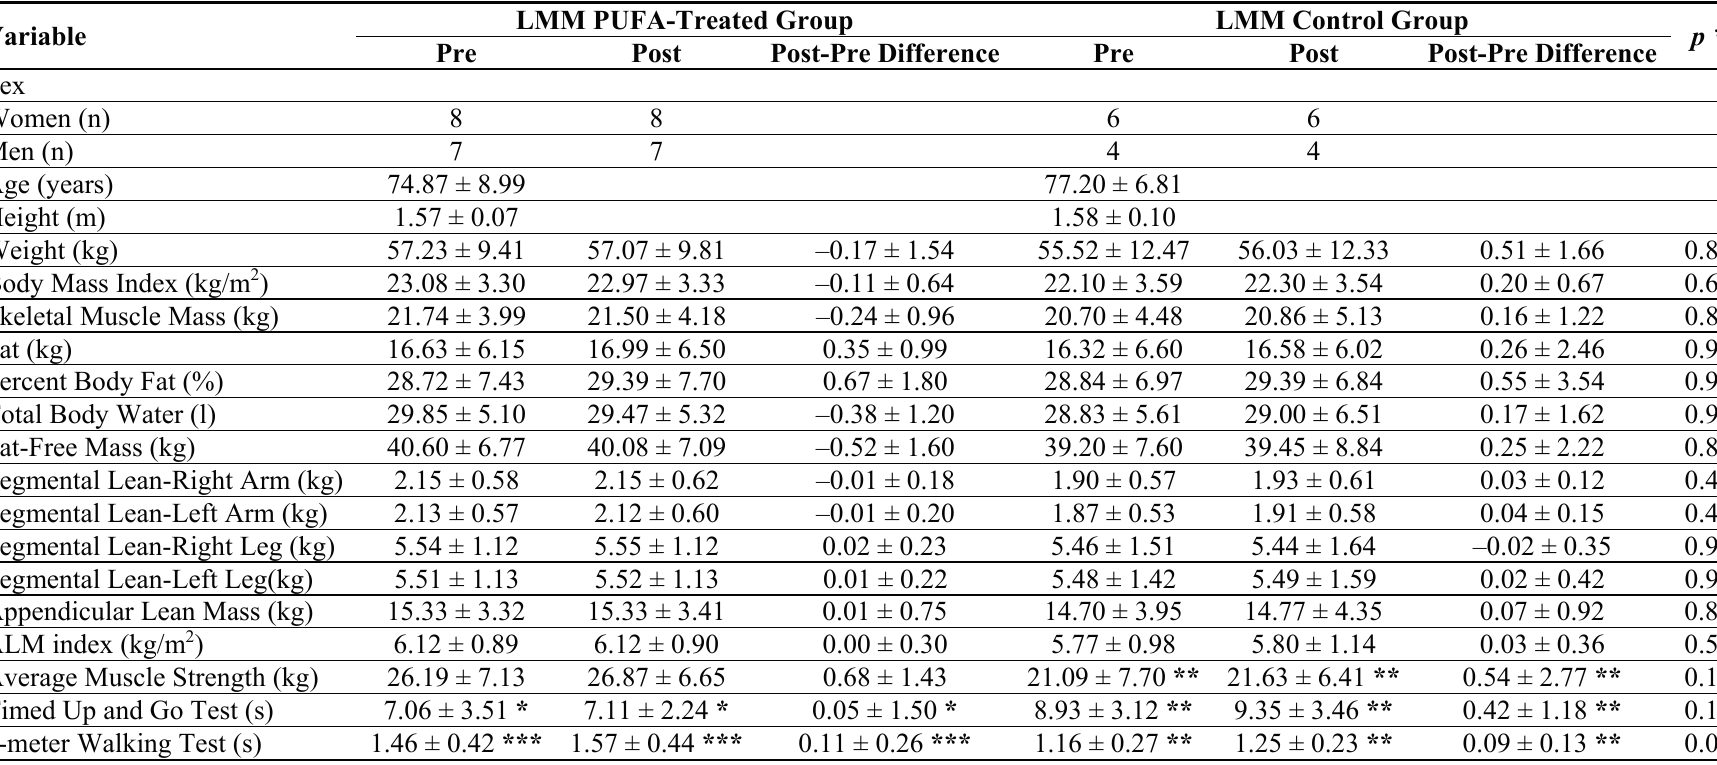
Table 5. Body composition, muscle strength and physical performance before and after 12-week intervention period in subjects with low muscle mass (LMM)